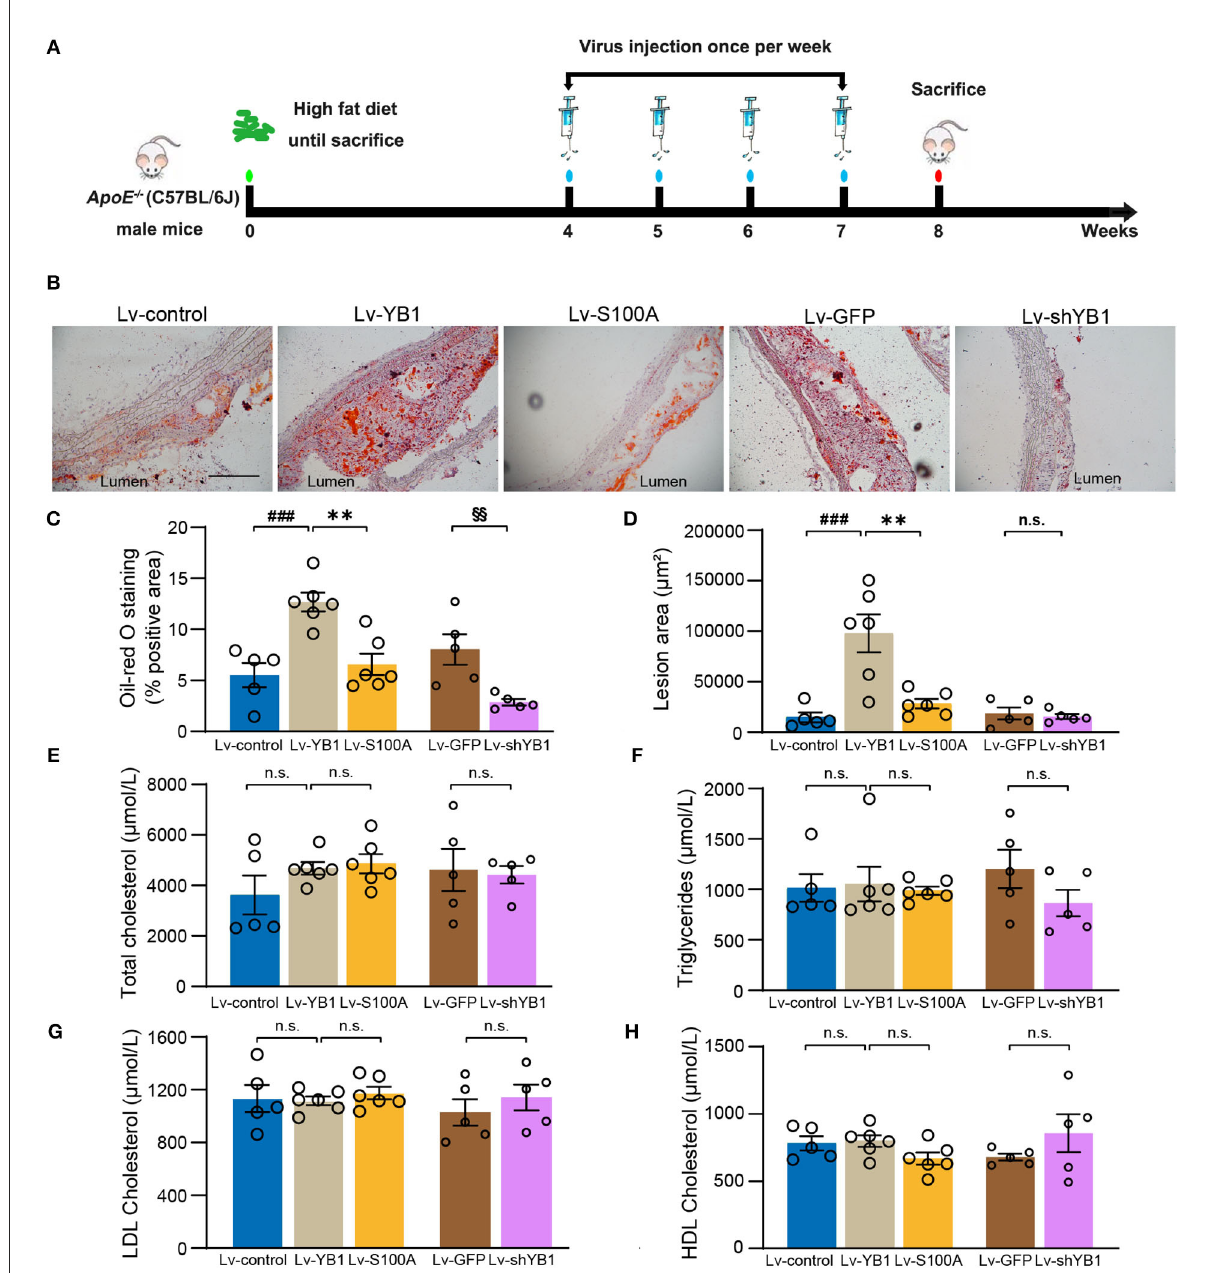
FIGURE3 YB1 dephosphorylation attenuates atherosclerosis in ApoE − / − mice. (A) Schematic diagram of the experimental animal model of atherosclerosis with lentivirus infection. (B) Representative images of Oil Red O staining of the aortic arch, and the related quantitative analysis (C) . (D) Lesion area quantification of the aortic arch. (E–H) Serum lipid profiles. Data are presented as the mean ± SEM. One-way ANOVA or Student’s two-tailed t -test. ### P < 0.001 vs. Lv-control, ** P < 0.01 vs. Lv-YB1, §§ P < 0.01 vs. Lv-GFP. N.S. indicated the data have no statistical difference. Scale bar = 100 µ m ( n = 5 or 6 for each